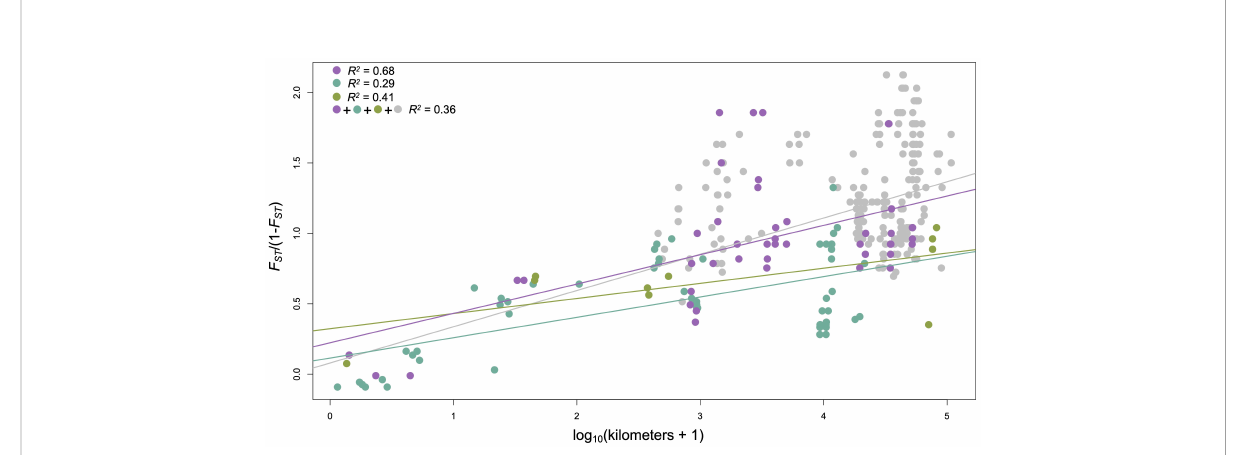
FIGURE 3 Correlations of geographic and genetic distance within Structure -de fi ned groups (at K = 3; colors match those used in Figure 1) and for all comparisons across genetically de fi ned populations (gray + colored points). See Table S2 for additional detail.